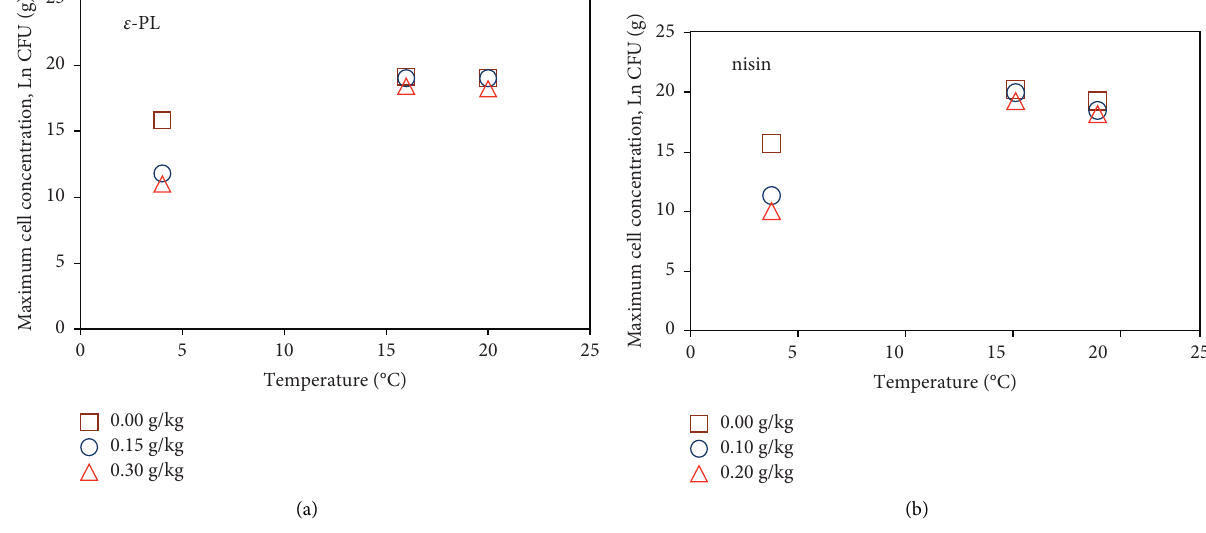
Figure 3: The maximum population of L. lactis in FVFB: (a) ε -PL treated and (b) nisin